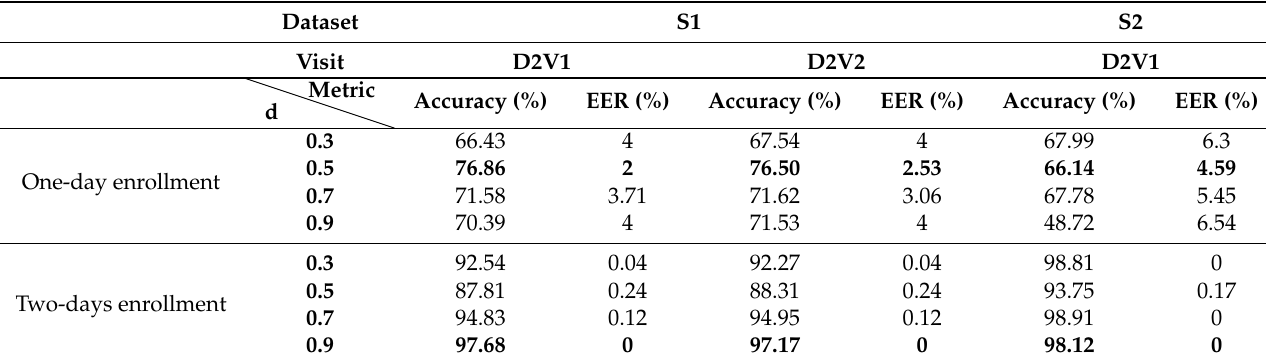
Table 5. Identification and verification results for different days in S1 and S2 for scenario R. The best considered options for one-day and two-days enrollment are in bold